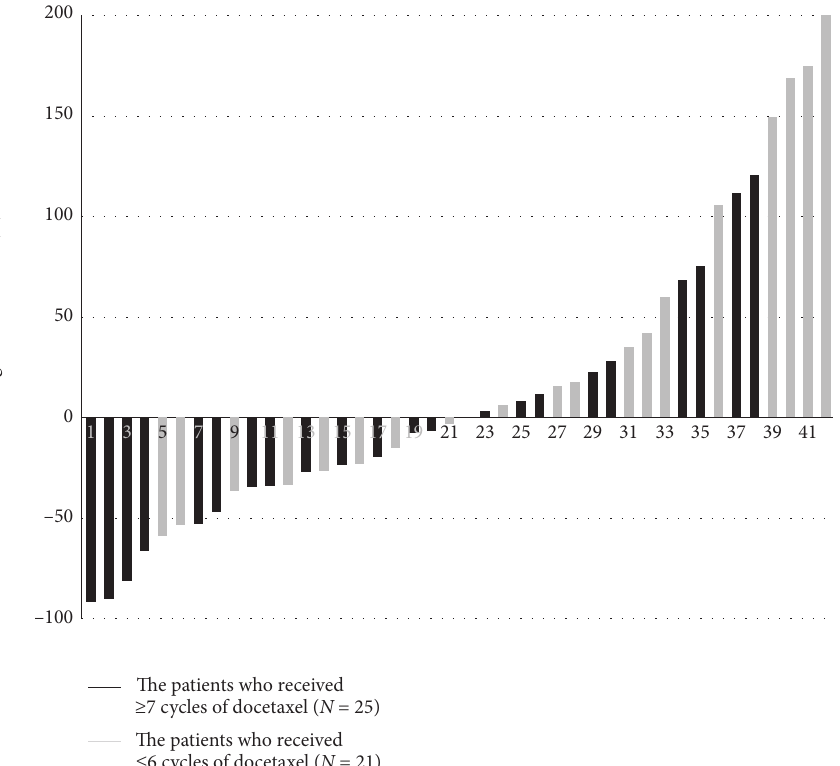
Figure 1: Waterfall plot of the maximum percentage change in prostate-specific antigen (PSA) levels from baseline. The median rates of ≥ 30% and ≥ 50% reduction in PSA levels after the induction of cabazitaxel in patients with metastatic castration-resistant prostate cancer who received ≥ 7 cycles of docetaxel (DOC) followed by cabazitaxel (CBZ) were higher than those in patients who received ≤ 6 cycles of DOC followed by CBZ, but there were no significant differences in both groups ( P � 0 . 742 and P > 0 . 999,